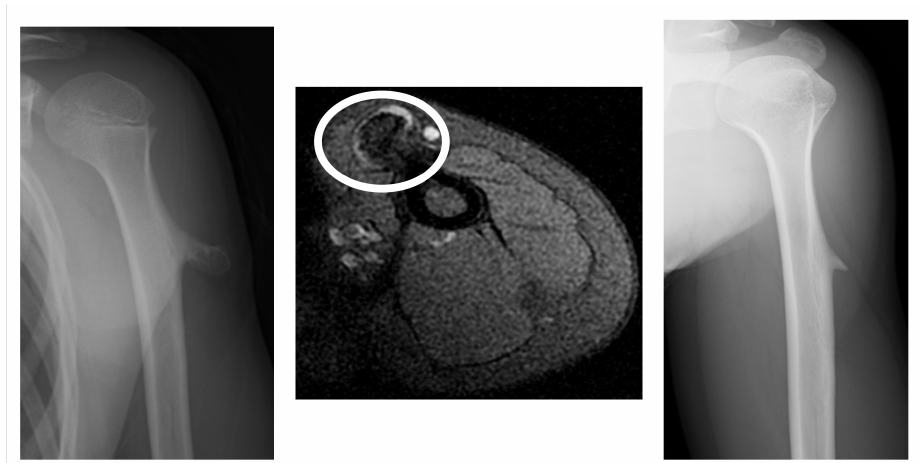
Figure 3. Radiographs revealing a pedunculated-type osteochondroma of the proximal humerus (left). At initial diagnosis, the thickness of the cartilage cap is 2.25 mm (circle) on MRI (middle). Two years later, regression of osteochondroma was observed